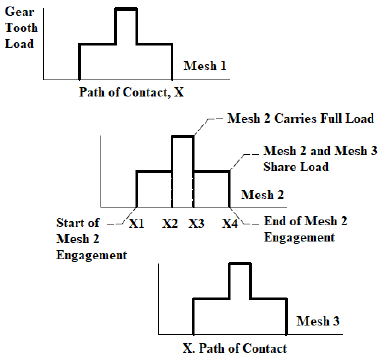
Figure 1. Tooth load-sharing diagram [9].